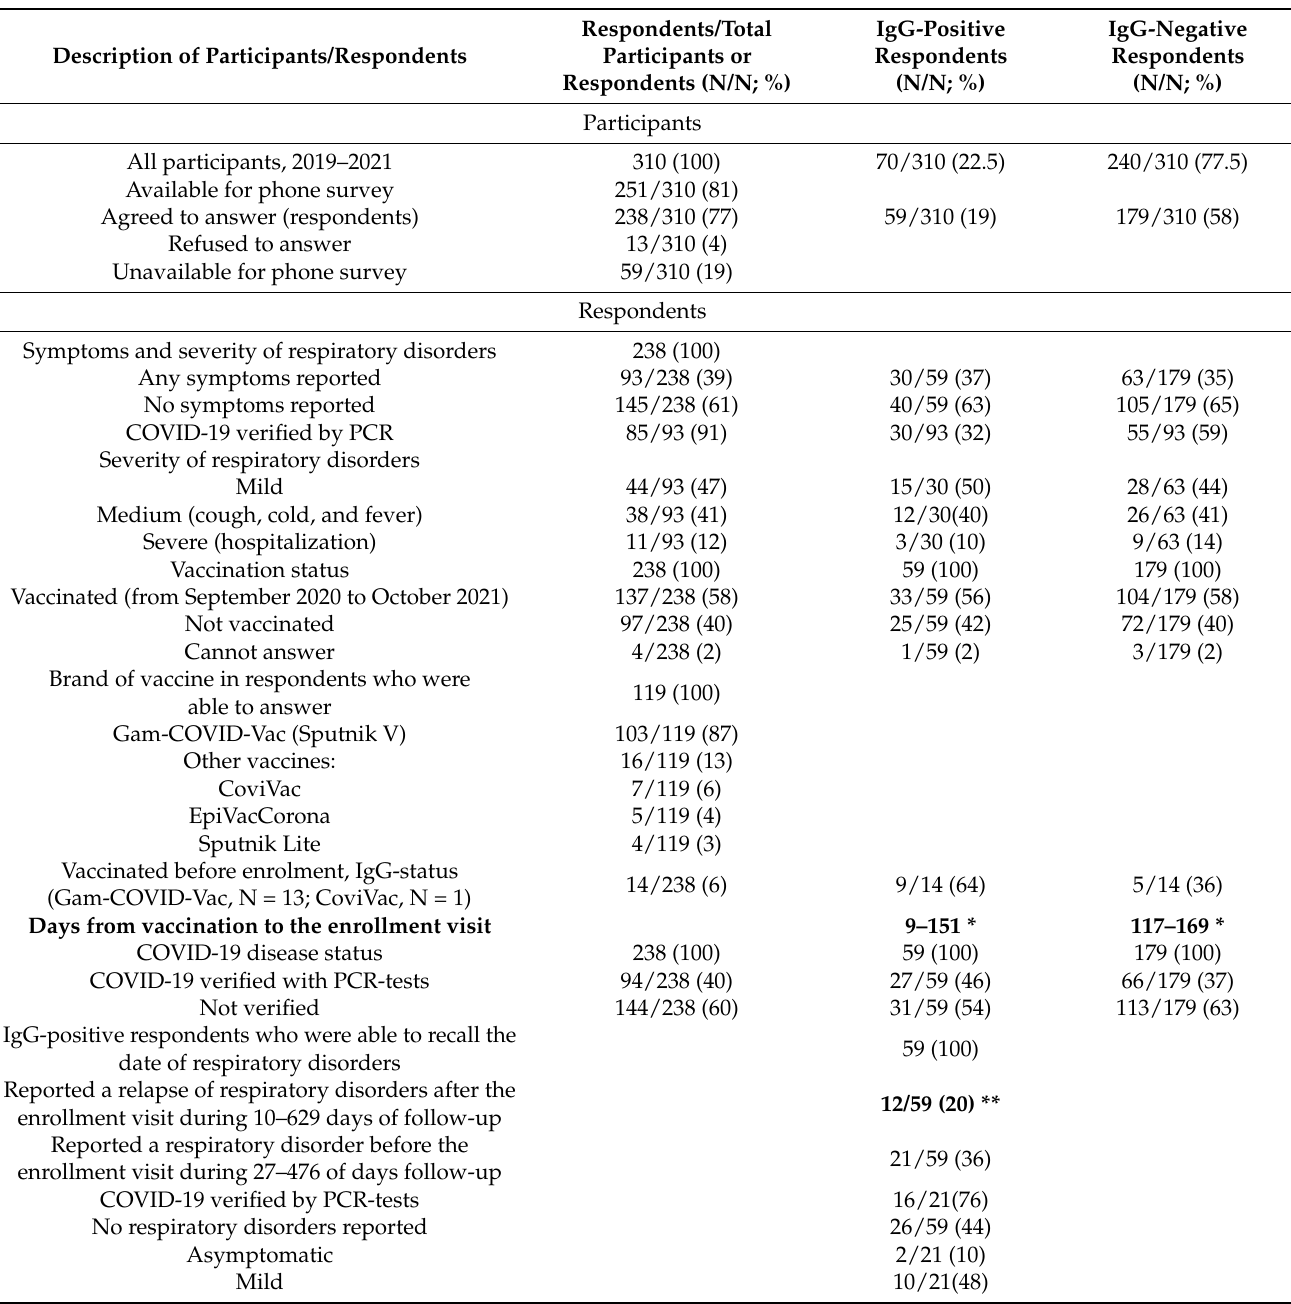
Table 3. COVID-19 infections in respondents enrolled in